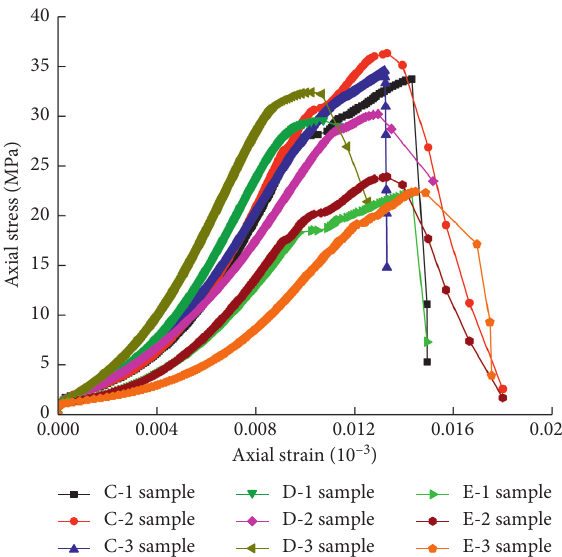
Figure 4: Stress-strain curve of the Table 2: Physical and mechanical parameters of the combined sample.